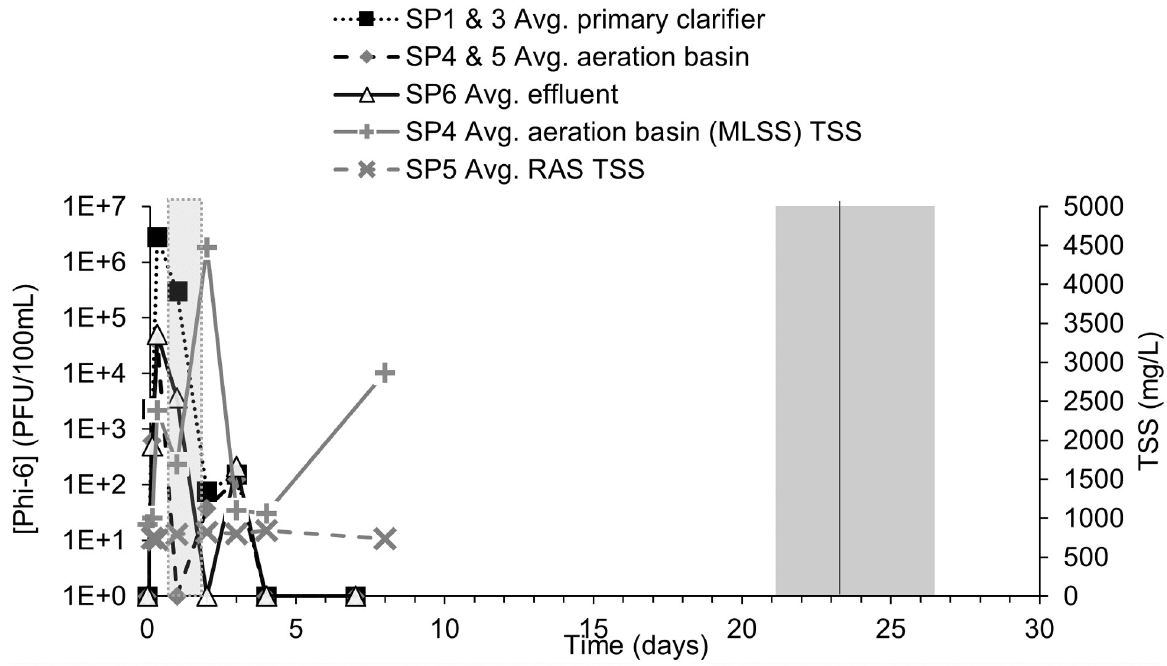
Fig 8. Averaged MS2 concentrations and TSS in the RAS and aeration basin effluent. The light gray block shows the HRT range of 0.75 to 1.75 days. The black vertical line is the average calculated SRT of 23 ± 2 days and the darker gray bar represents the SRT possible range of 21–26.4 days. SP1 and SP3 were averaged for “Average primary clarifier.” SP4 and SP5 were averaged for “Average aeration basin.” The “+” and “x” series show the TSS in the aeration basin effluent and RAS, respectfully. Error bars removed for clarity (Original data in S2 Text).